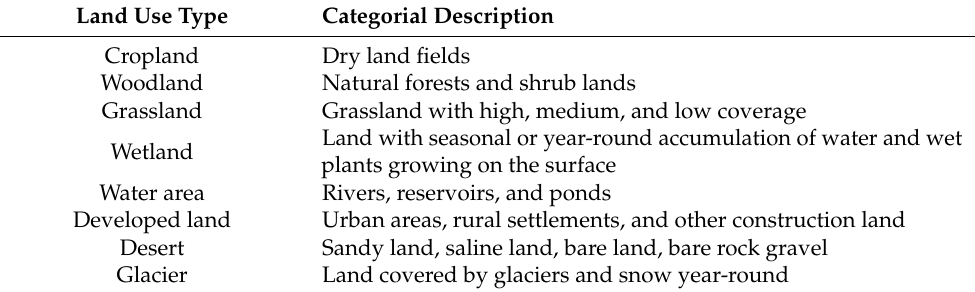
Table 2. Reclassification of land use types in the